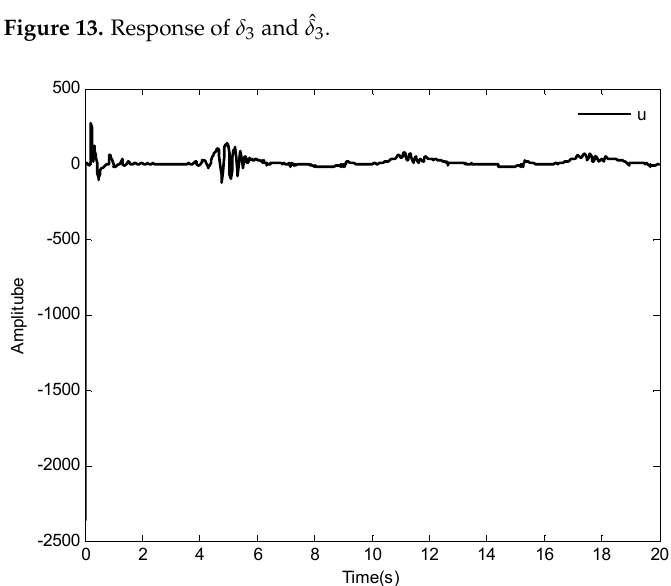
Figure 14. The curve of control input u ( t ) .